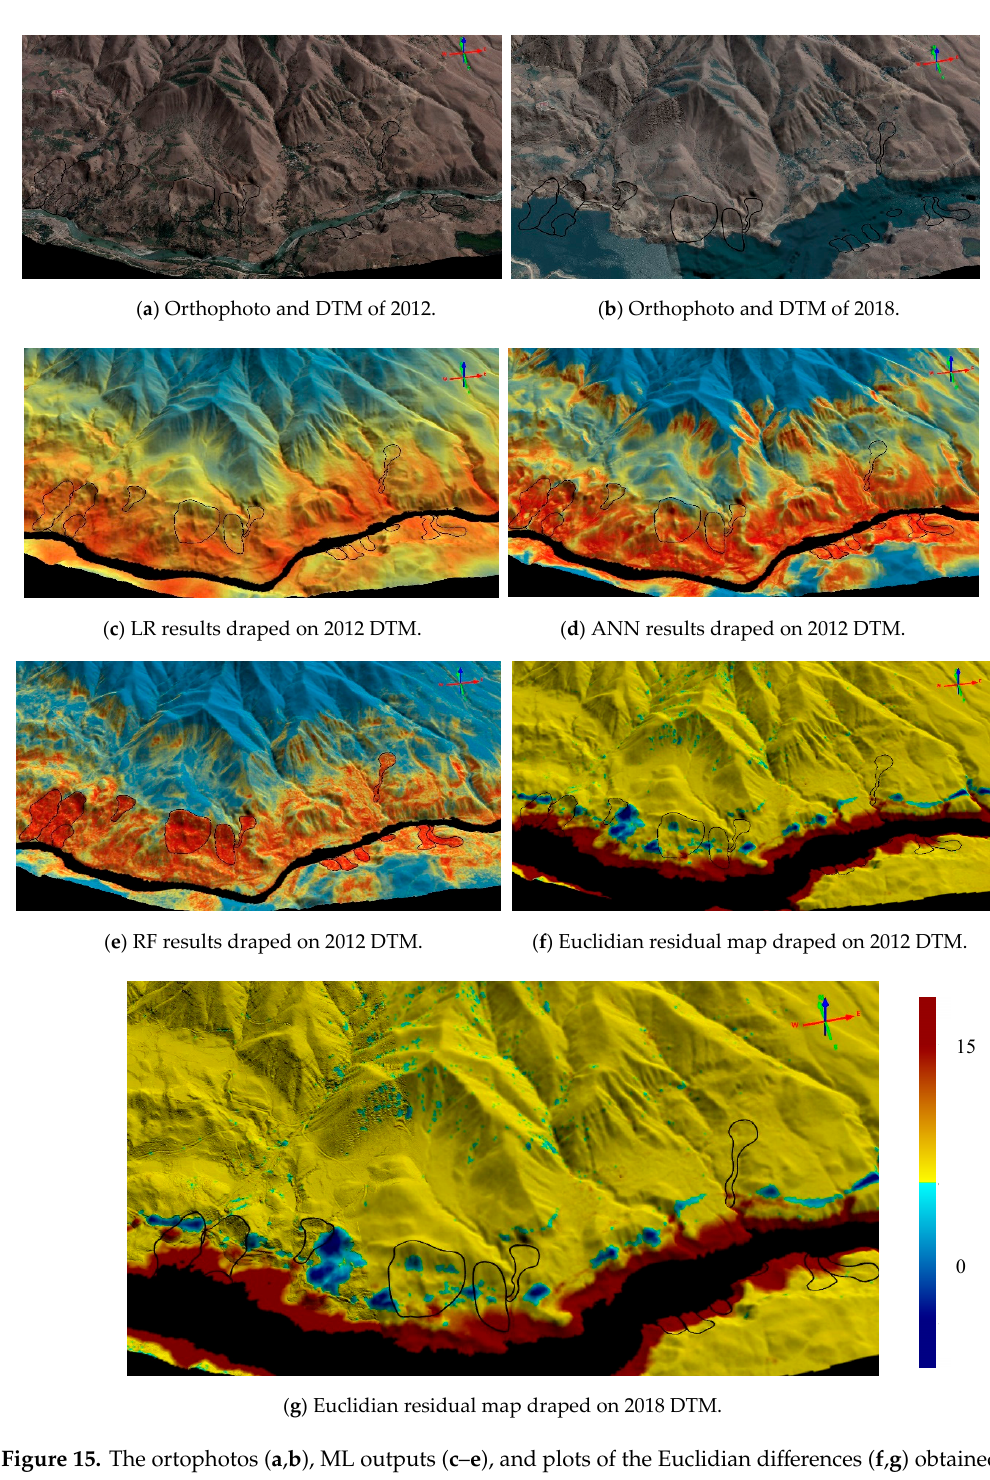
from the comparison between 2012 and 2018 DTMs of the study area. The road area is shown here.